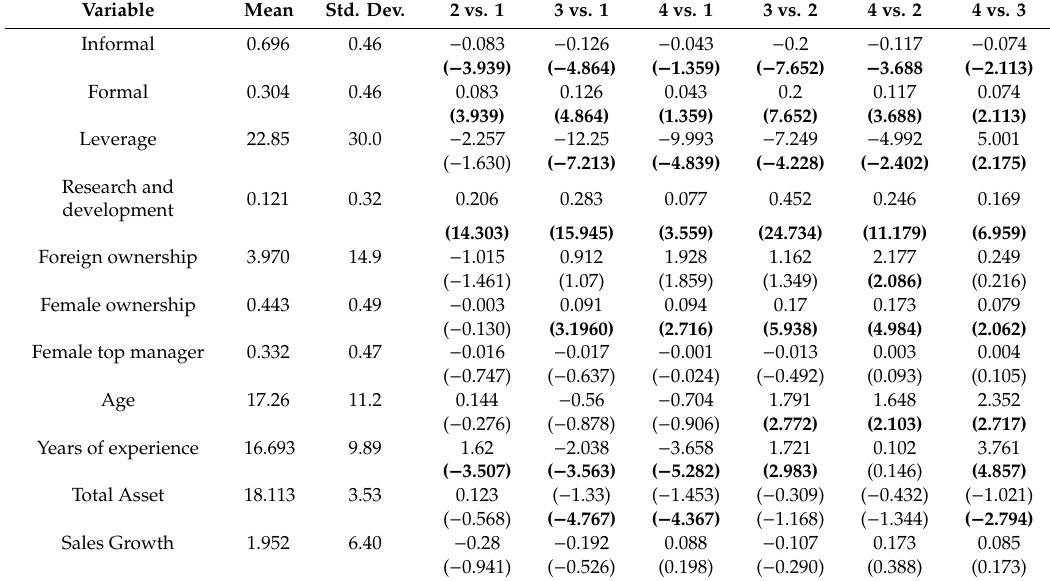
Table 2. Descriptive statistics and pairwise mean di ff